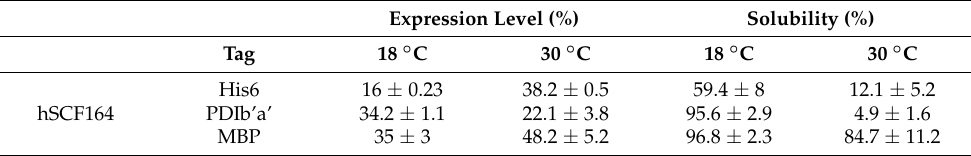
Figure 2. Expression and solubility analysis of fusion protein in E. coli . ( a ) His-hSCF164, ( b ) PDIb’a’-hSCF164, and ( c ) MBP-hSCF164 plasmids were transformed into Origami 2(DE3) strain, and the fusion proteins were expressed. His-hSCF248 plasmid was transformed into ( d ) Origami 2(DE3) and ( e ) BL21(DE3) strain, and the protein was expressed. Protein expression was induced by 0.5 mM IPTG at 18 °C and 30 °C. The red arrows indicate the His-hSCF164 (22 kDa), PDIb’a’-hSCF164 (52.6 kDa), MBP-hSCF164 (62.4 kDa), and His-hSCF248 (31.9 kDa). M, molecular weight size marker; C, total proteins before induction; I, total protein after induction; P, insoluble portion after cell lysis; S, soluble supernatant after cell lysis. Table 1. Expression levels and solubilities of His-hSCF164, PDIb’a’-hSCF164, and MBP-hSCF164 in Origami 2(DE3) from triplicated experiments.